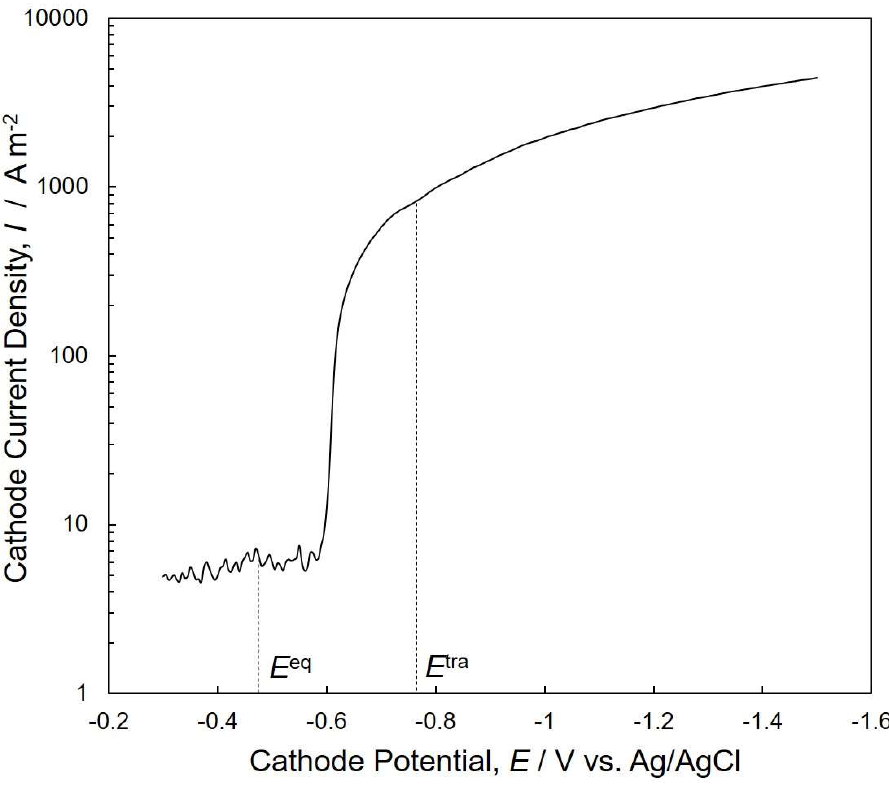
Figure 4. Cathode polarization curve for Co electrodeposition from an aqueous solution containing CoCl 2 and H 3 BO 3 . The solution temperature was kept to 80 °C .